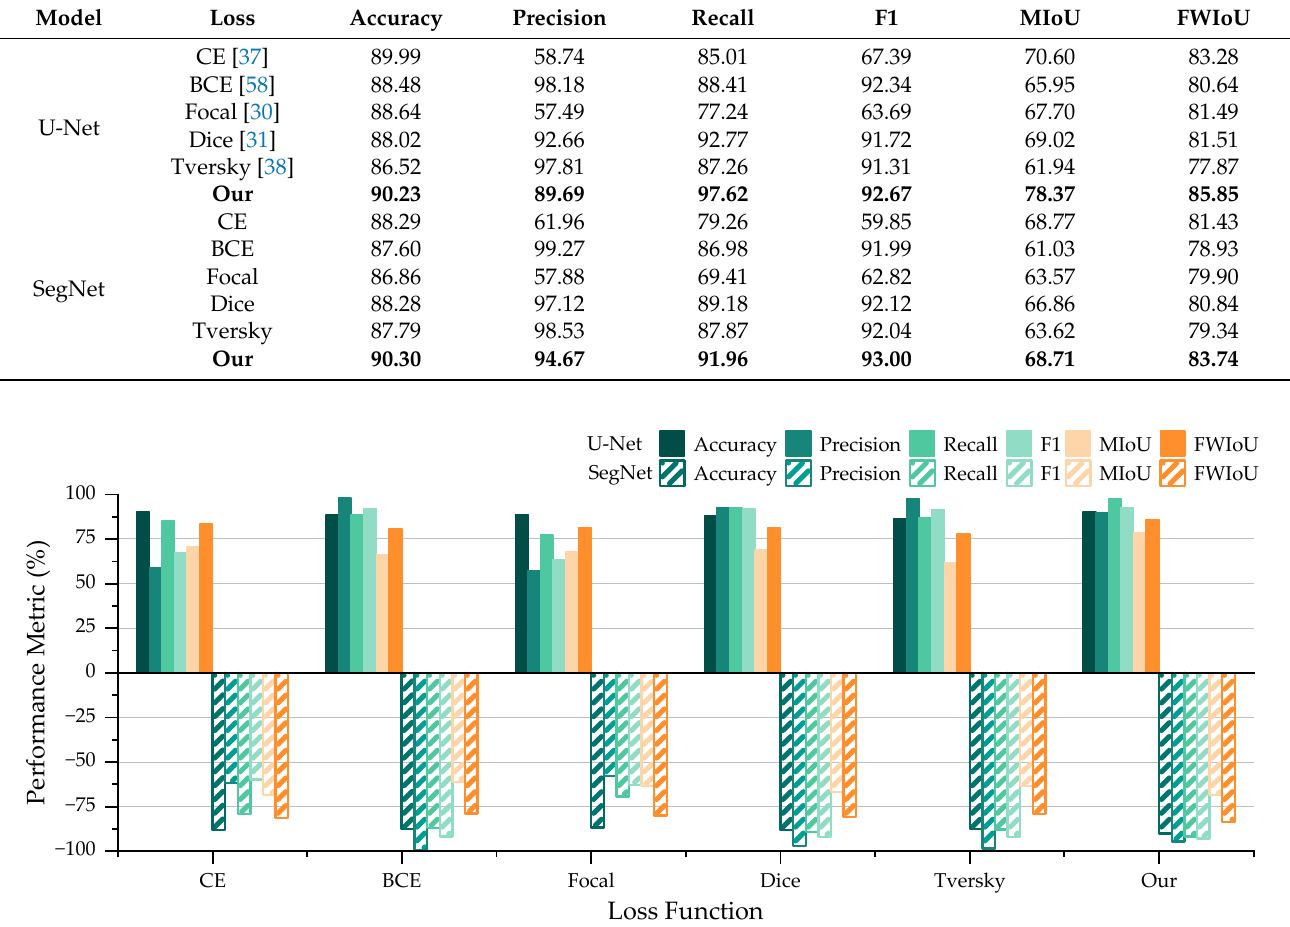
Figure 14. The histogram of various loss functions on network performance metric (%).